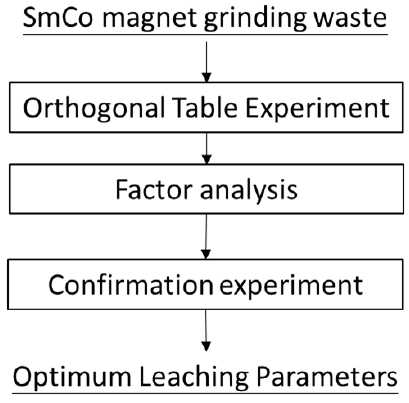
Figure 1. Leaching flow chart. Table 2. Control factors and selection levels.